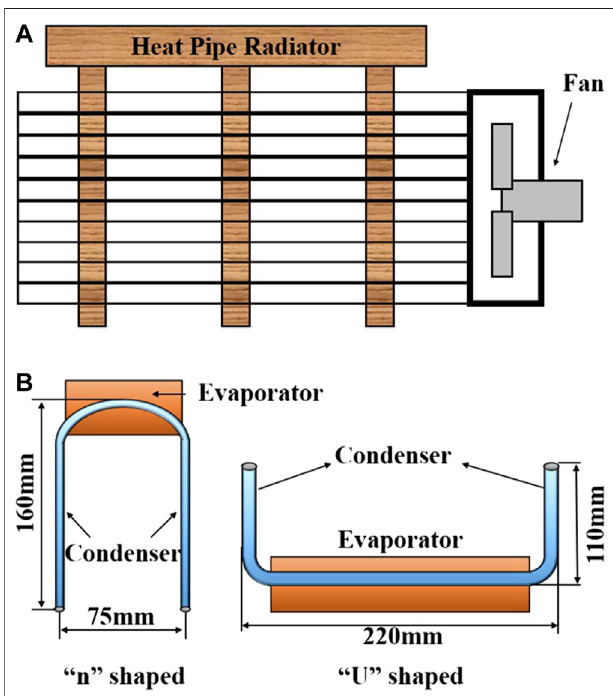
FIGURE 12 | (A) Schematic diagram of typical heat pipe cooling device structure; (B) Structure diagram of U-type and n-type heat pipe radiator. Adapted from [55].